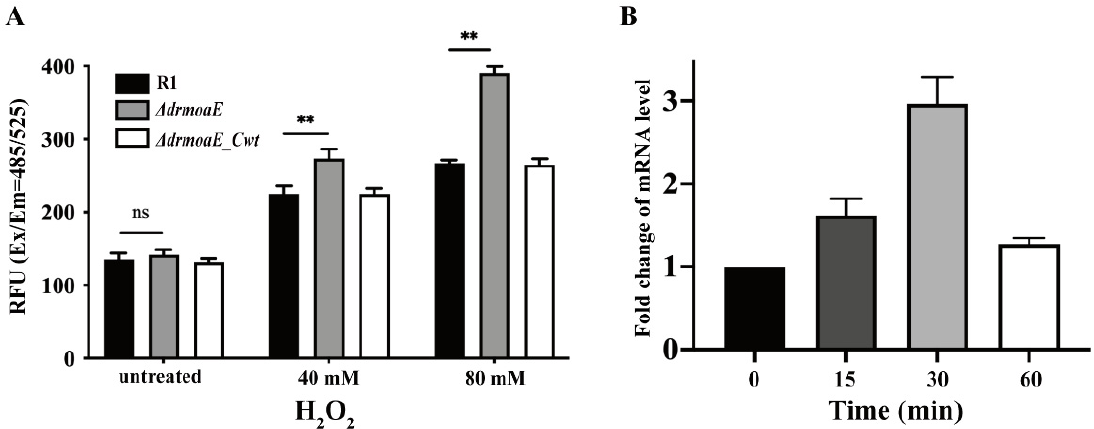
Figure 4. Antioxidant function of DrMoaE. (A) The level of ROS accumulation in cells after 0, 40, and 80 mM H 2 O 2 treatment, respectively. “Untreated” represents a concentration of 0 mM H 2 O 2 . RFU means relative fluorescence units. Each value represents the mean of three assays (mean ± SD). “ns” means not significant. ** p < 0.01 . (B) The mRNA levels of drmoaE after exposure to 40 mM H 2 O 2 for 0, 15, 30, and 60 min. Each value represents the mean of three assays (mean ± SD).